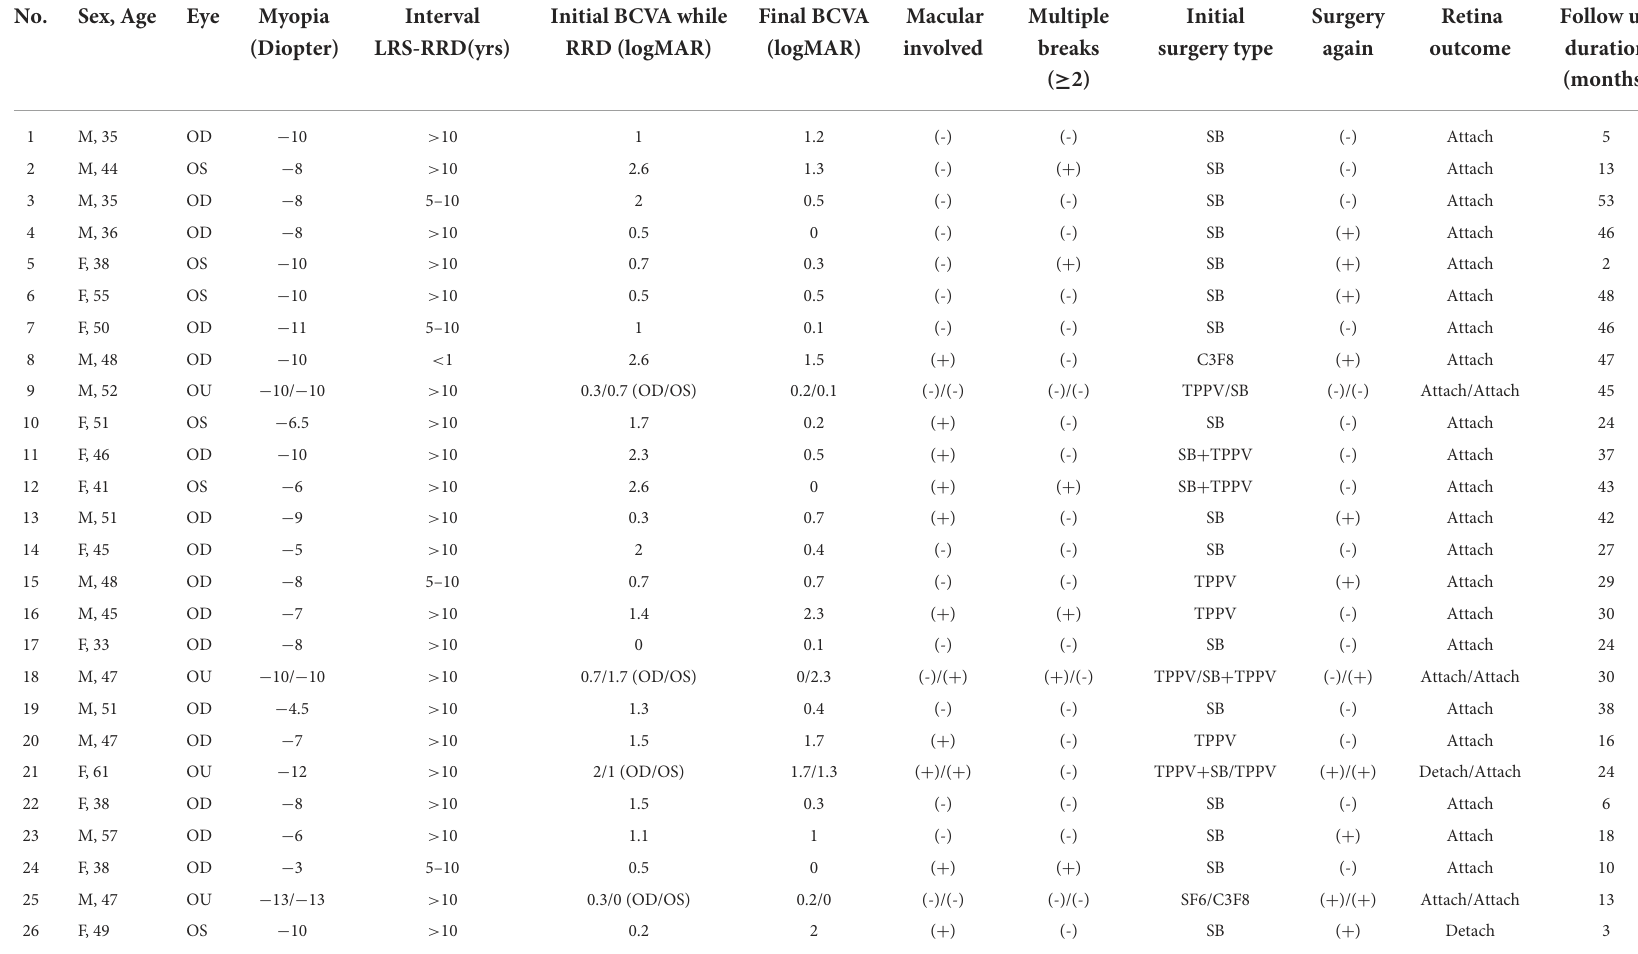
TABLE 1 Characteristics and surgical outcomes of rhegmatogenous retinal detachment patients with previous laser refractive surgery for myopia.